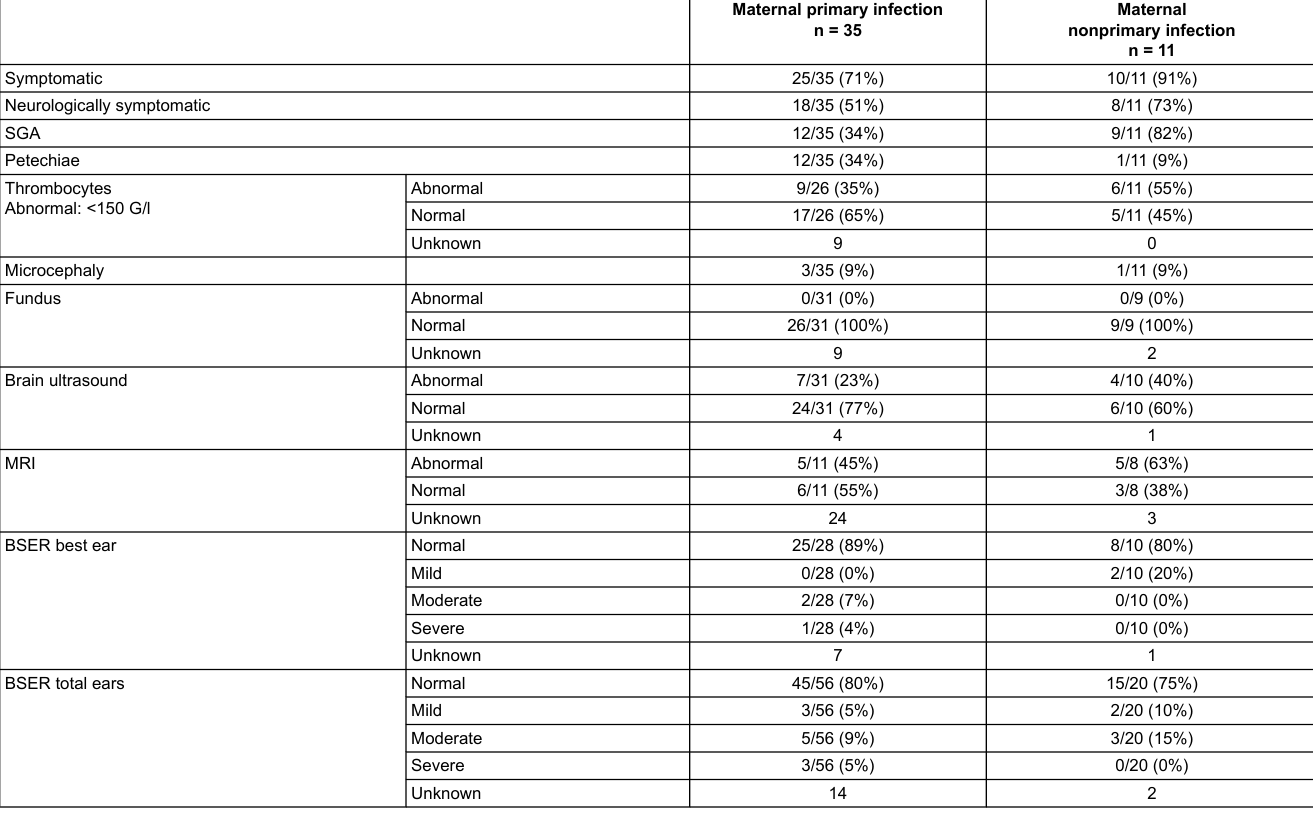
Maternal primary infection n = 35